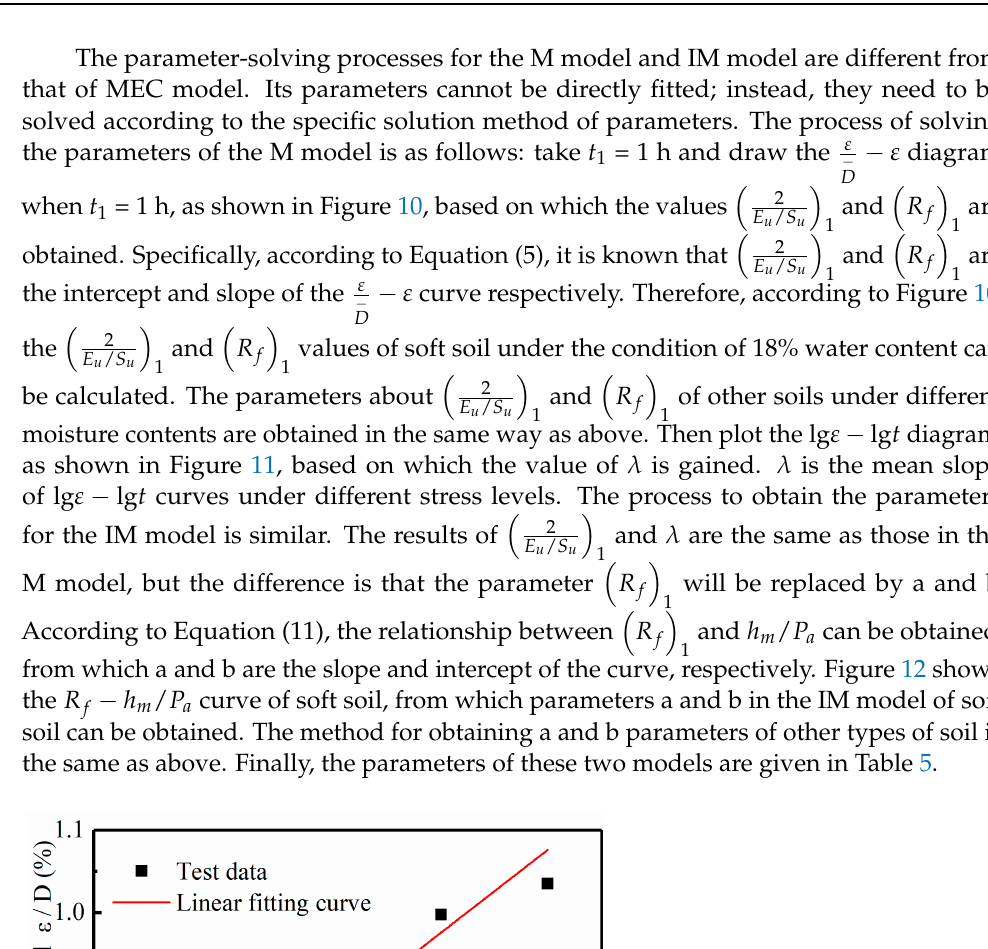
Figure 10. The ε